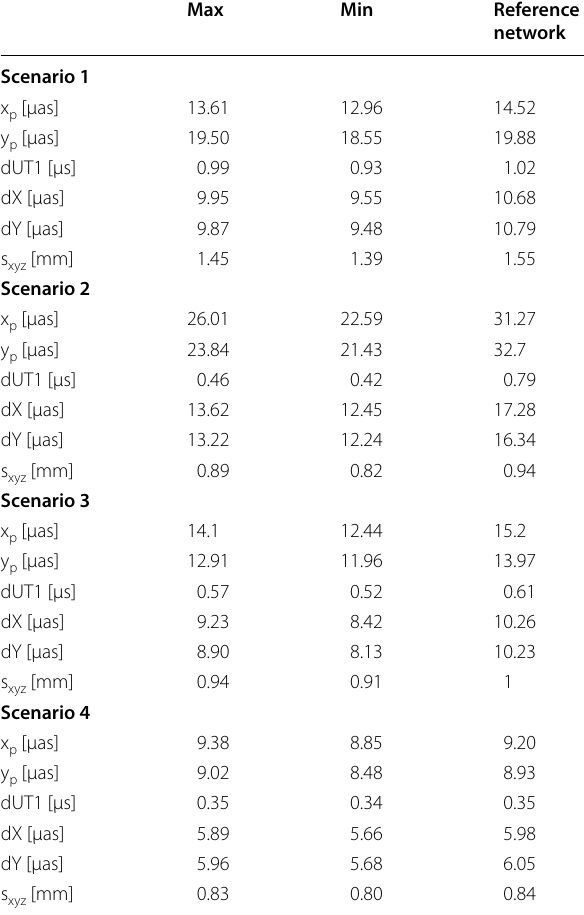
Table 5 Maximum and minimum values of mean formal errors among all study locations and that of the reference network in each scenario